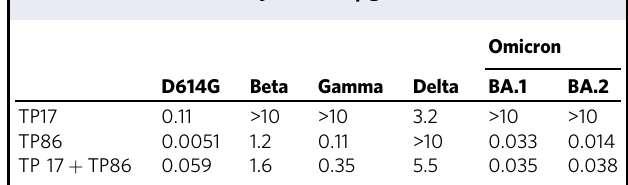
Table 1 IC50 of nanobody clones ( μ